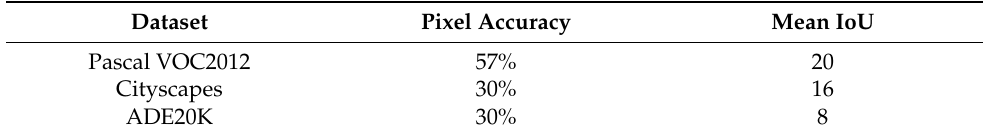
Table 4. Results of the architecture of the three